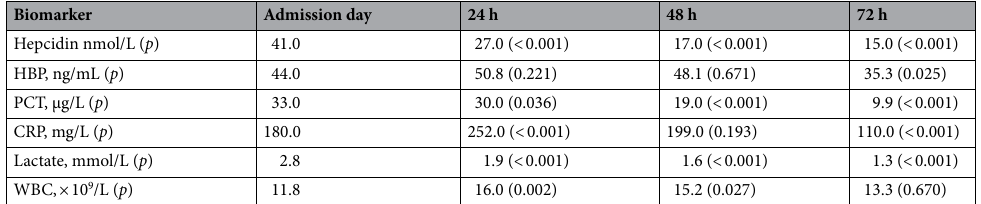
Table 3. Change in biomarker levels in relation to arrival values. Median values of biomarkers during the first 72 h in the sepsis group. P values from Wilcoxon’s signed rank test, presenting if there is any significant change in biomarker levels between current value and arrival value. A p value < 0.05 is considered significant.